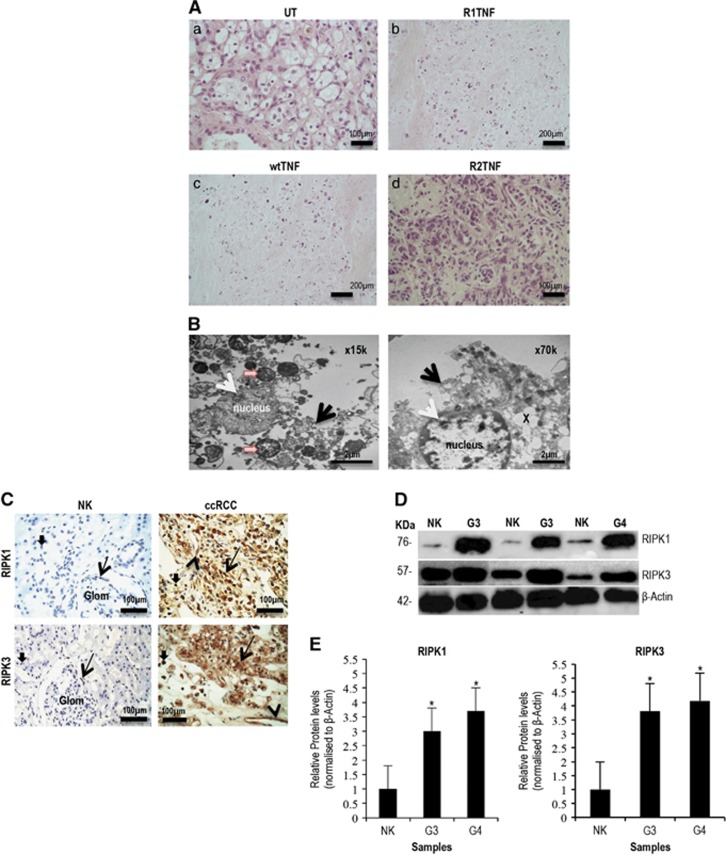
(A) Histology of untreated cultures (UT) show (a) low-grade RCC with small round tumor cells and a clear cytoplasm surrounded by a distinct cell membrane and round uniform nuclei with inconspicuous or absent nucleoli. (b) R1TNF- and (c) wtTNF-treated cultures show elevated level of death in mTECs compared with (d) R2TNF-treated cultures. (B) Morphological features of necrosis are evident in R1TNF-treated cultures such as large/small cytoplasmic vacuoles (x), condensation of the chromatin into small, irregular, circumscribed patches (white arrow), increasing translucent cytoplasm, swollen organelles (orange arrow) and disruption of the plasma membrane (black arrows). (C) Expression of RIPK1 and RIPK3 in tissue biopsies comprising RCC and NK; NK show a rare signal for RIPK1 and RIPK3 in MNCs within glomeruli (arrows) and with interstitium (small arrows). In contrast, RCC grade 3 shows marked signal in mTECs (arrows), MNCs (small arrows) and in some VECs (arrowheads). (D and E) Representative immunoblot of samples from nine patients with similar results and bar graph of relative RIPK1 and RIPK3 protein levels in grades 3/4 RCC (G3/G4) and non-tumor kidney (NK). Bars=mean+S.E.M.; *P<0.05 versus NK; paired Student's t-test. Glom-glomeruli; MNCs-mononuclear cells; TECs-tubular epithelial cells